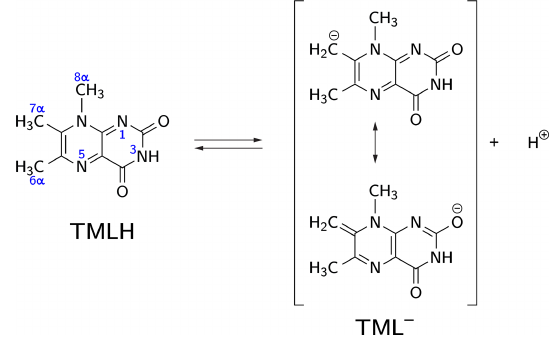
Figure 1. CH acidity of the methyl group attached to position 7 in 6,7,8-trimethyllumazine. The deprotonated (anionic) form TML − can be drawn in various mesomeric structures, two of which are depicted on the right-hand